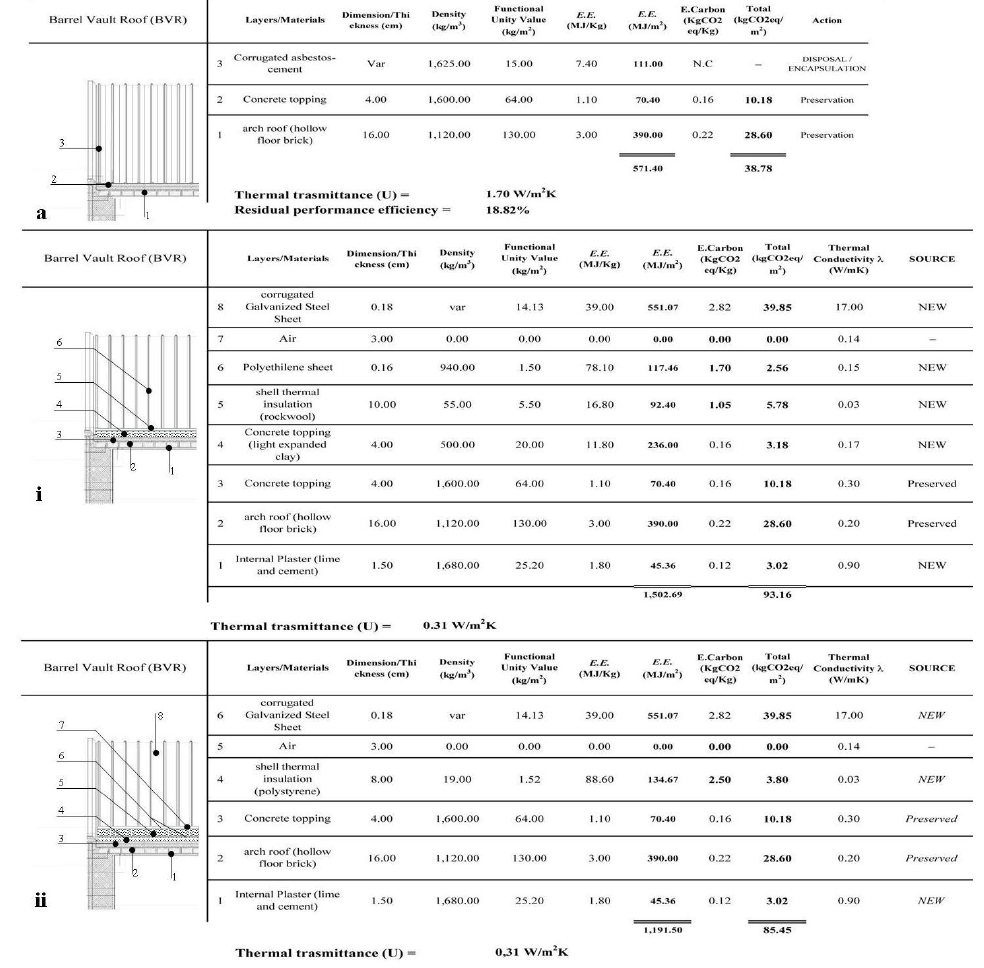
Figure 12. Analysis of building elements: current status ( a ); with insulation in polystyrene ( i ); with insulation in rockwool ( ii ).